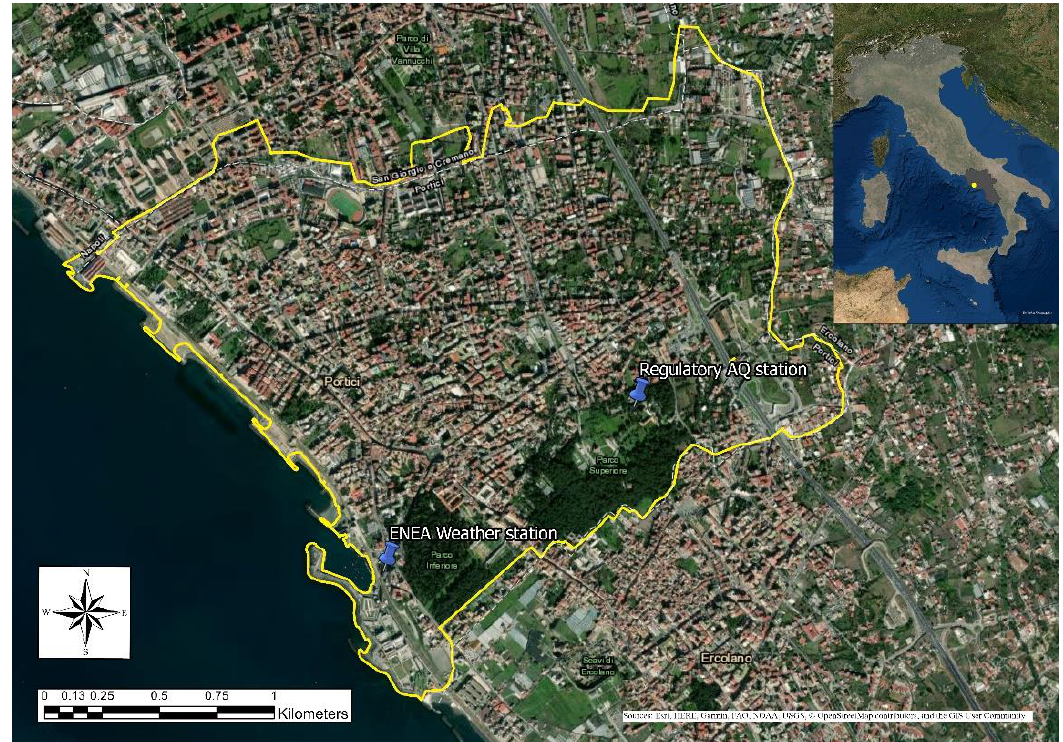
Figure 1. Map of the City of Portici (South Italy) with the ENEA RC weather station and the regulatory air quality monitoring station.